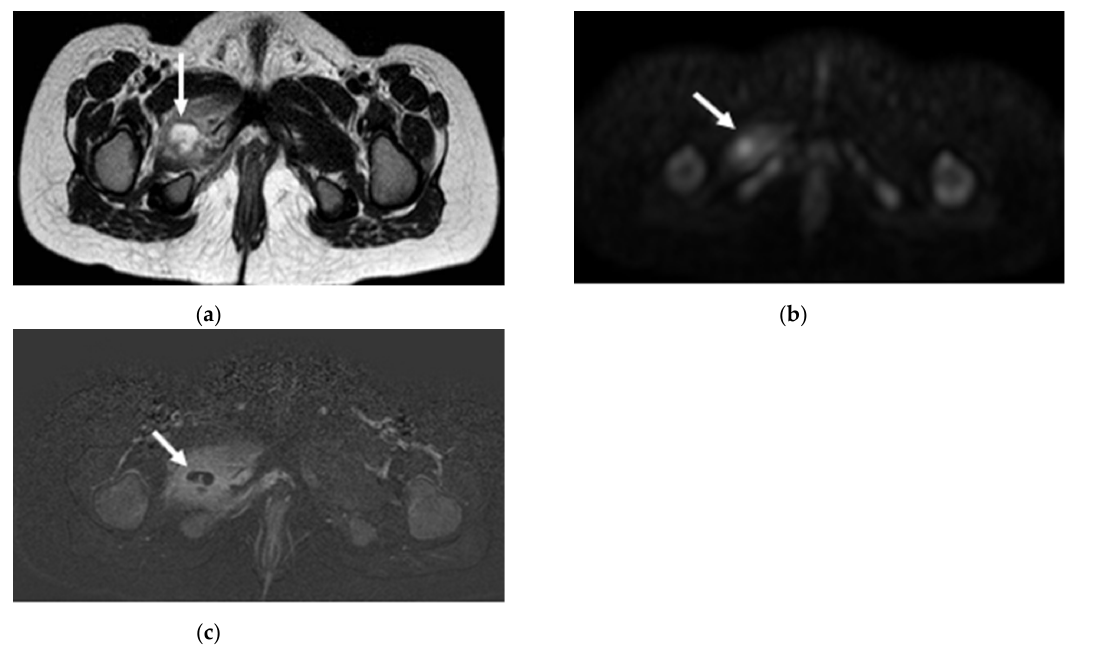
Figure 3. A 5-year-old boy with pyomyositis of the right obturator muscles and osteomyelitis of the right hip bones. ( a ) Soft tissue ultrasound and ( b ) hip X-ray are negative. ( c ) Axial fat suppressed T2-weighted magnetic resonance (MR) image shows muscle edema and an abscess in the obturator internus muscle. On ( d ) fat suppressed axial T1-weighted post-contrast image the abscess shows hypointense fluid collection with rim enhancement. MR images show hyperintensity of the right pubic bone (osteomyelitis).